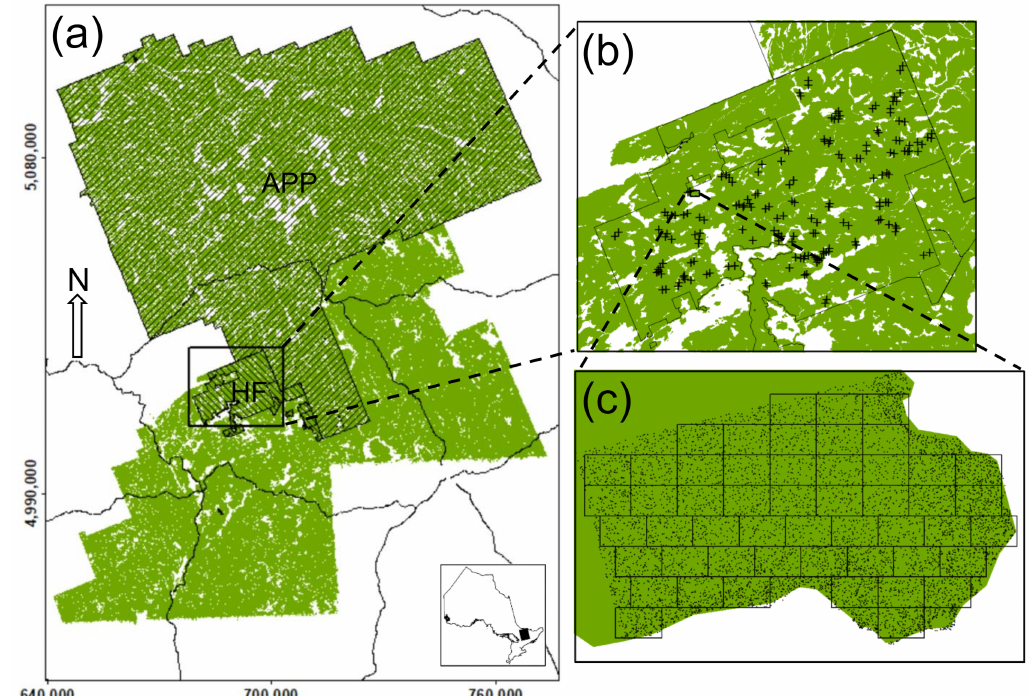
Figure 1. Map of the study area in south-central Ontario, Canada, showing geographical coordinates (UTM 17N, WGS84), major roads (black), Algonquin Provincial Park (APP), Haliburton Forest (HF), map location within Ontario (inset), and Forest Resource Inventory information (green) that was used in combination with Sentinel-2 satellite information to model percent tree species composition ( a ). White areas are lakes and areas outside the study area. Also shown are locations of field-measured 0.25-ha plots (“plus” symbols; ( b )) and tree stems ≥ 10 cm DBH mapped in the “Megaplot” (dots) with superimposed 0.24-ha rectangular plots (black lines; ( c